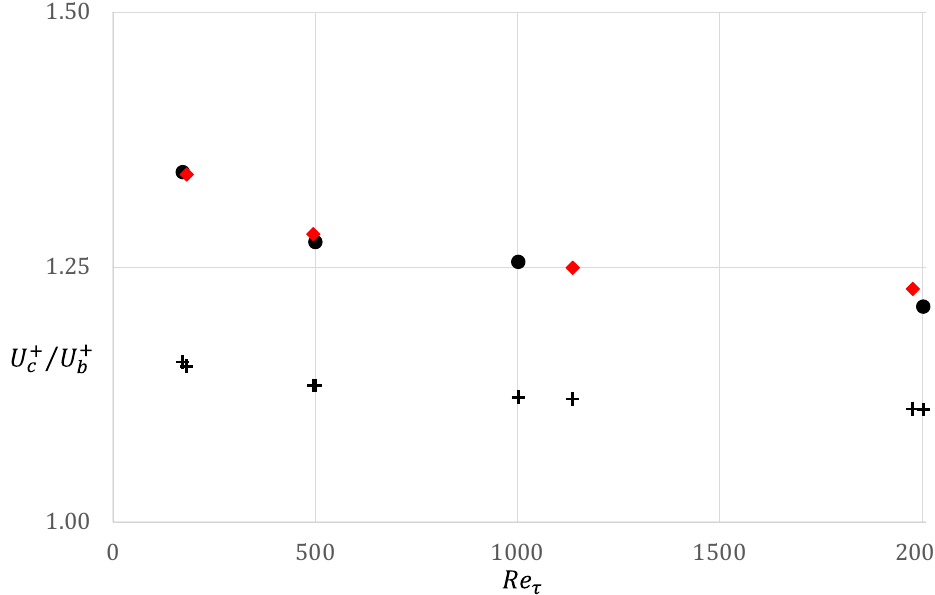
; • pipe DNS data [26]; 𝑐𝑐+ 𝑈𝑈